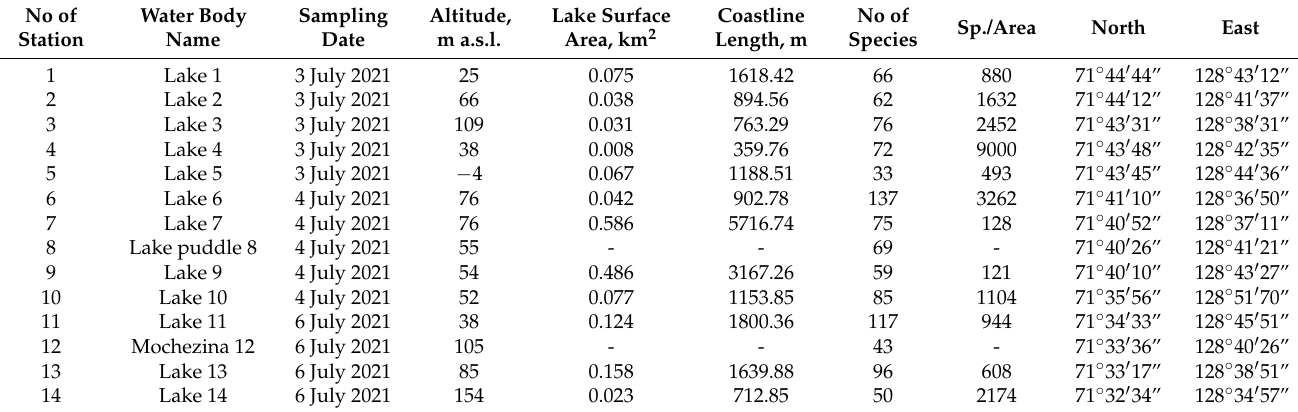
Figure 1. Sampling points on the studied water bodies in July 2021 with a wind rose. 1–14 are numbers of sampling points according to the Table 1. Table 1. Sampling station geographical coordinates and parameters.